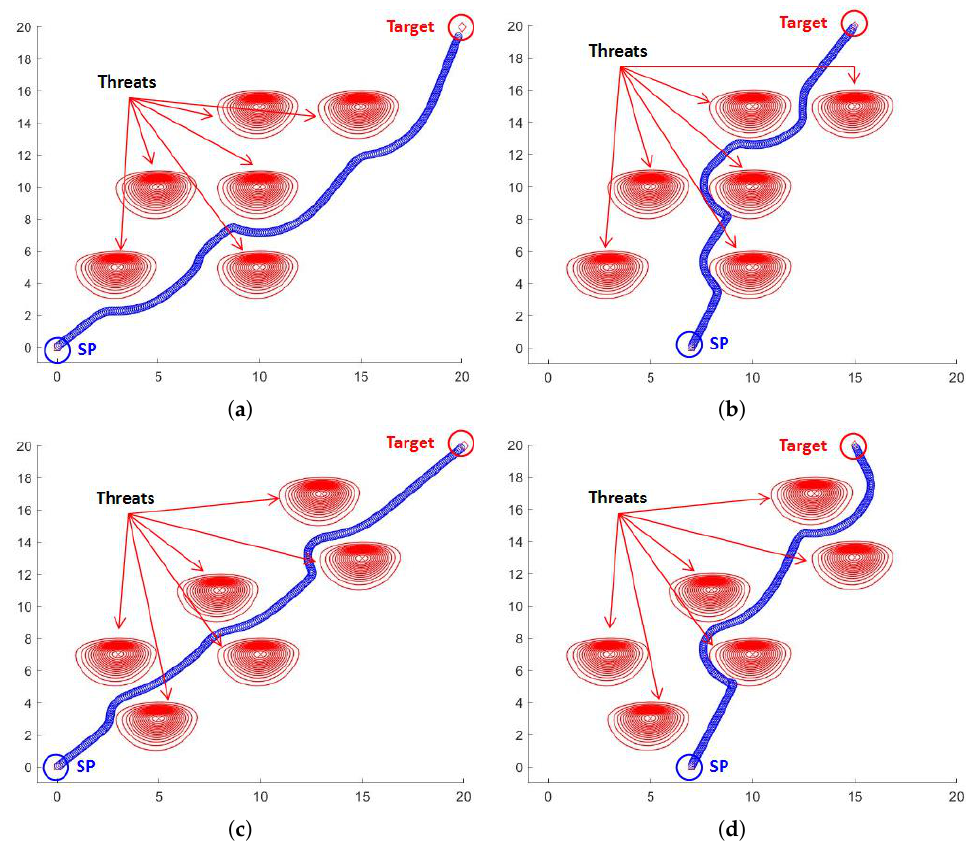
Figure 7. Path planning results in large instances: ( a ) Initial state of expanded instance. ( b ) Changing the start and target point. ( c ) Changing enemy threat positions. ( d ) Changing all components.